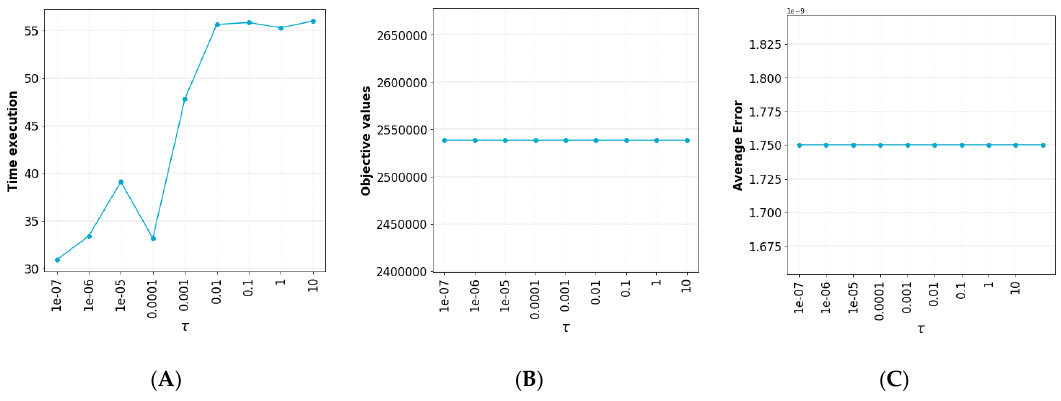
Figure 9. ( A ) the time execution of DCA with di ff erent values of τ ; ( B ) the objective value of DCA with di ff erent values of τ ; ( C ) average errors of the decision variables with di ff erent values of τ .